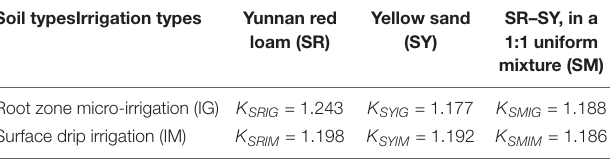
TABLE 4 | Correction coefficient K value table of soil moisture content measured. Soil typesIrrigation types Yunnan red